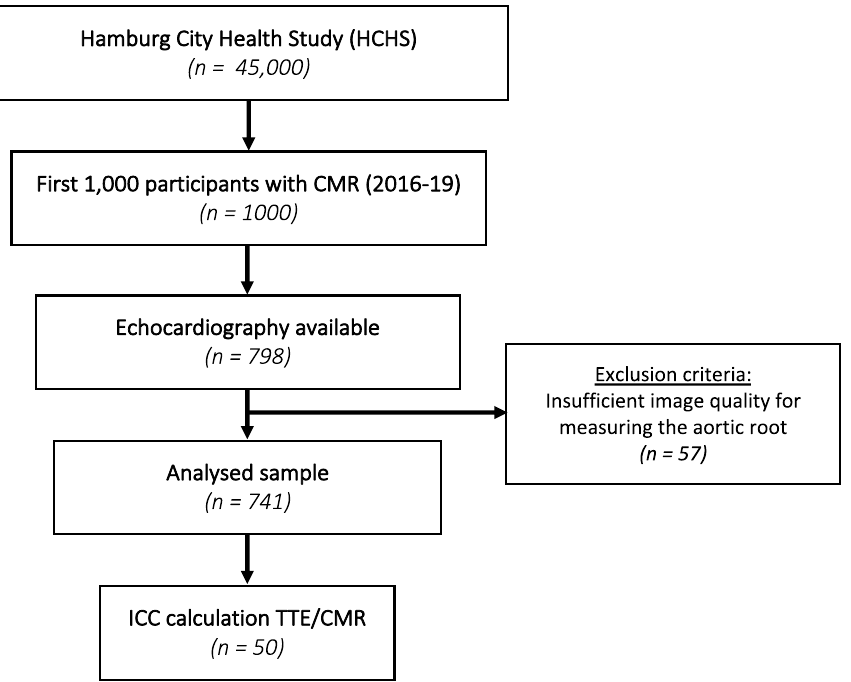
Figure 2. Study PRISMA. From the first 1000 HCHS subjects with CMR data, 798 subjects had undergone TTE examination, 57 were excluded due to insufficient echocardiographic or CMR image quality for measuring the aortic root. Inter and Intraobserver correlation coefficients were calculated for 50 at random selected subjects. CMR cardiac magnetic resonance imaging, ICC intra-/interclass correlation coefficient, TTE transthoracic